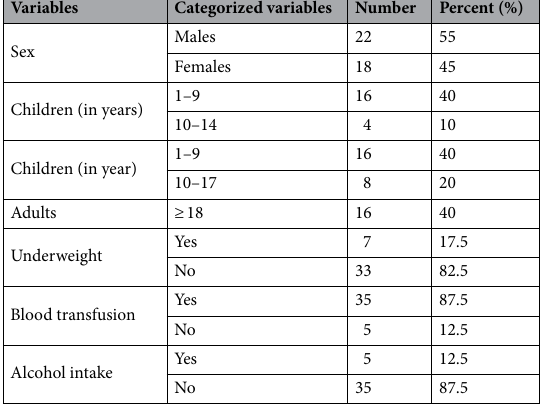
Table 3. Socio-demographic characteristics of patients with acute lymphoblastic leukaemia.